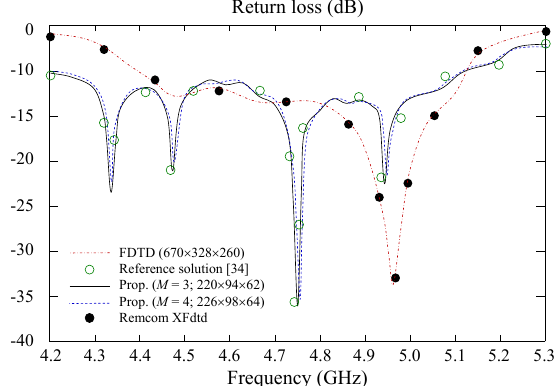
Figure 8: Magnitude of the S parameter versus actuators. 21 Table 1: Resonant frequencies of the coaxial waveguide Ref. = 396 cm, L = 14 cm, r x y